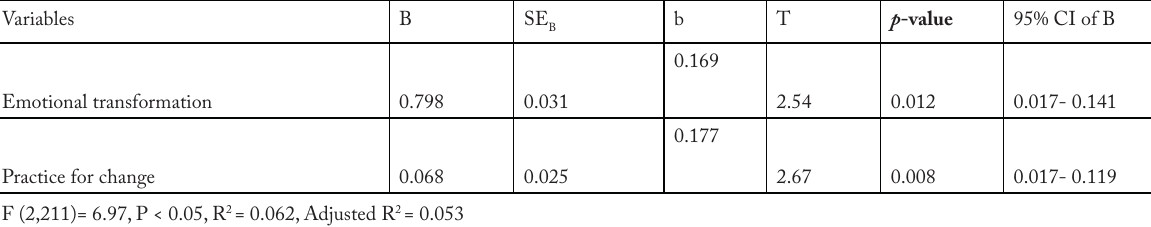
Table 4. Parameter estimates based on stepwise regression analysis* to predict intention for sustenance of physical activity behavior change using MTM